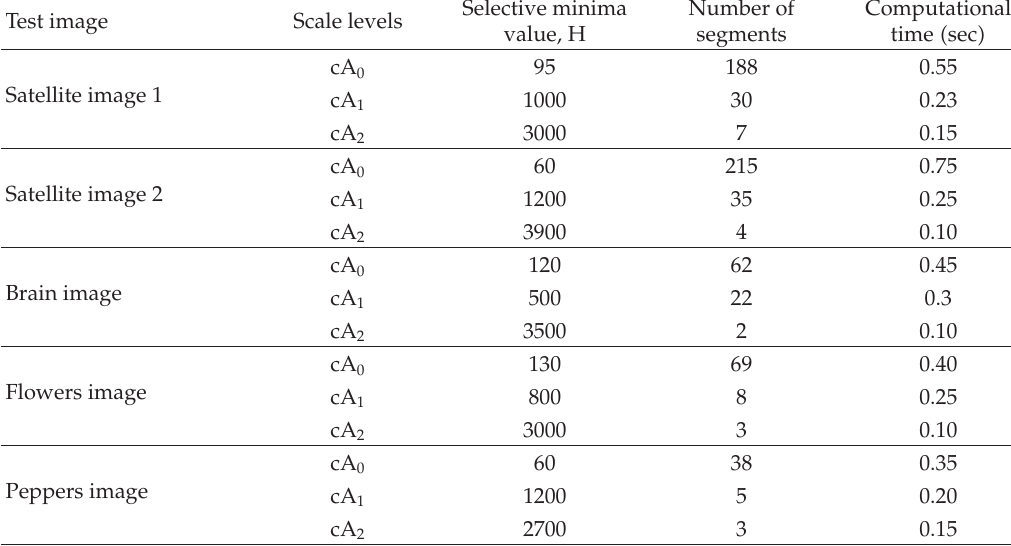
Table 1: The results of image segmentation on each